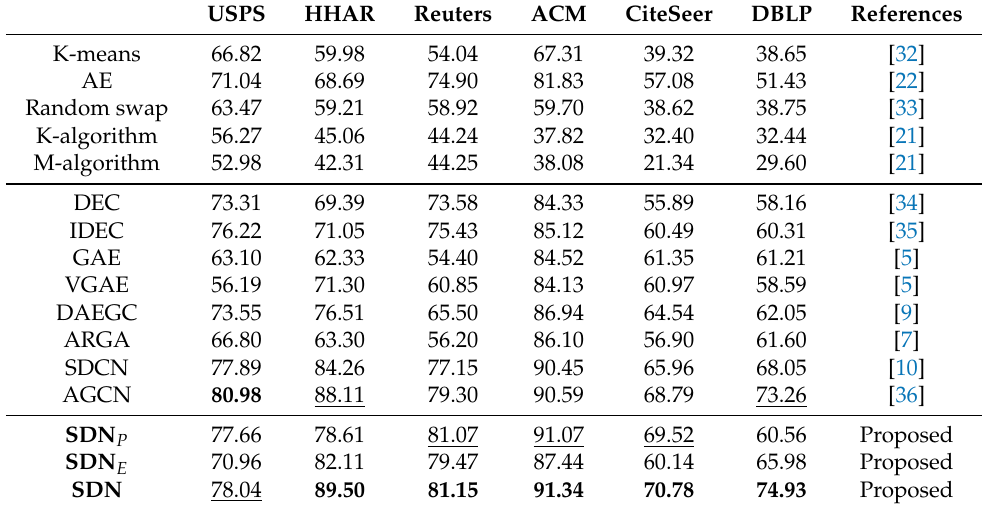
Table 5. Accuracy (ACC) results on six datasets.